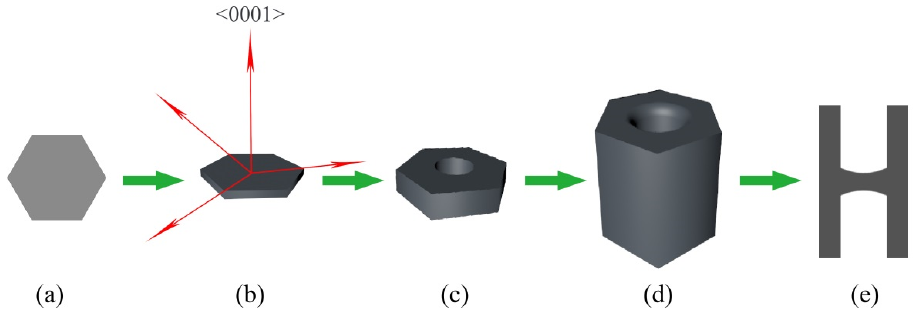
Figure 8. The growth processes of the core–shell structure Cu@Ti 5 Si 3 . ( a ) hexagonal chip; ( b ) solid hexagonal sheet; ( c ) cup-shaped structure; ( d ) hollow hexagonal prisms; ( e ) H-shaped core-shell rods.